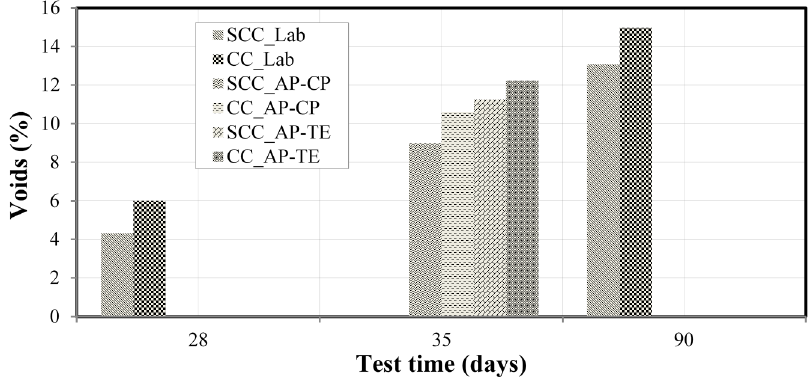
Figure 10. Results of void